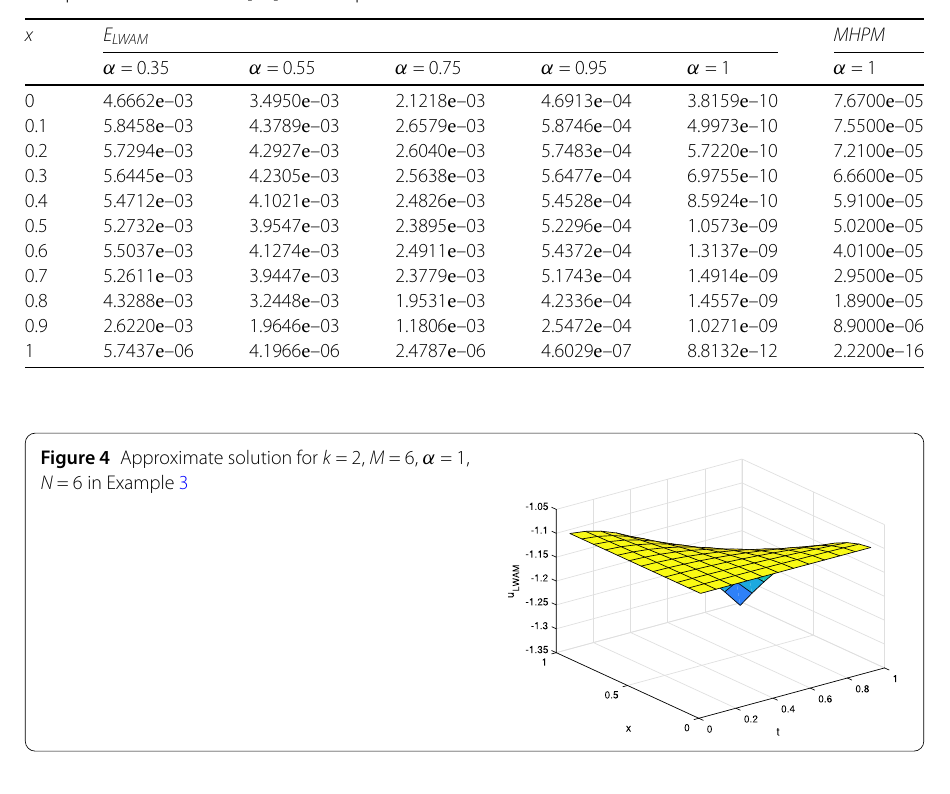
Table 5 Absolute errors for N = 6, k = 2, M = 6, t = 0.5, different values of α going to α = 1, and comparison with MHPM [38] in Example 3